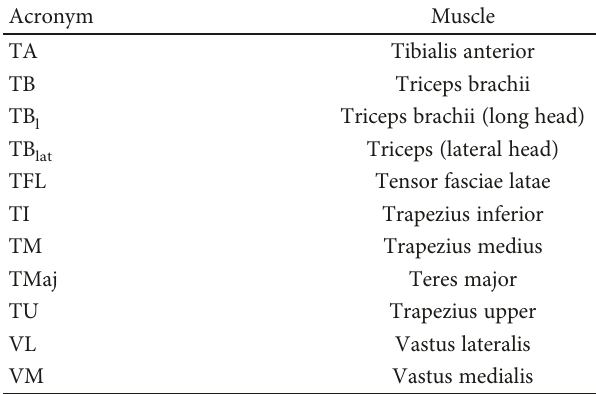
Table 2: Acronyms of human full-body muscles. Table 2: Continued.